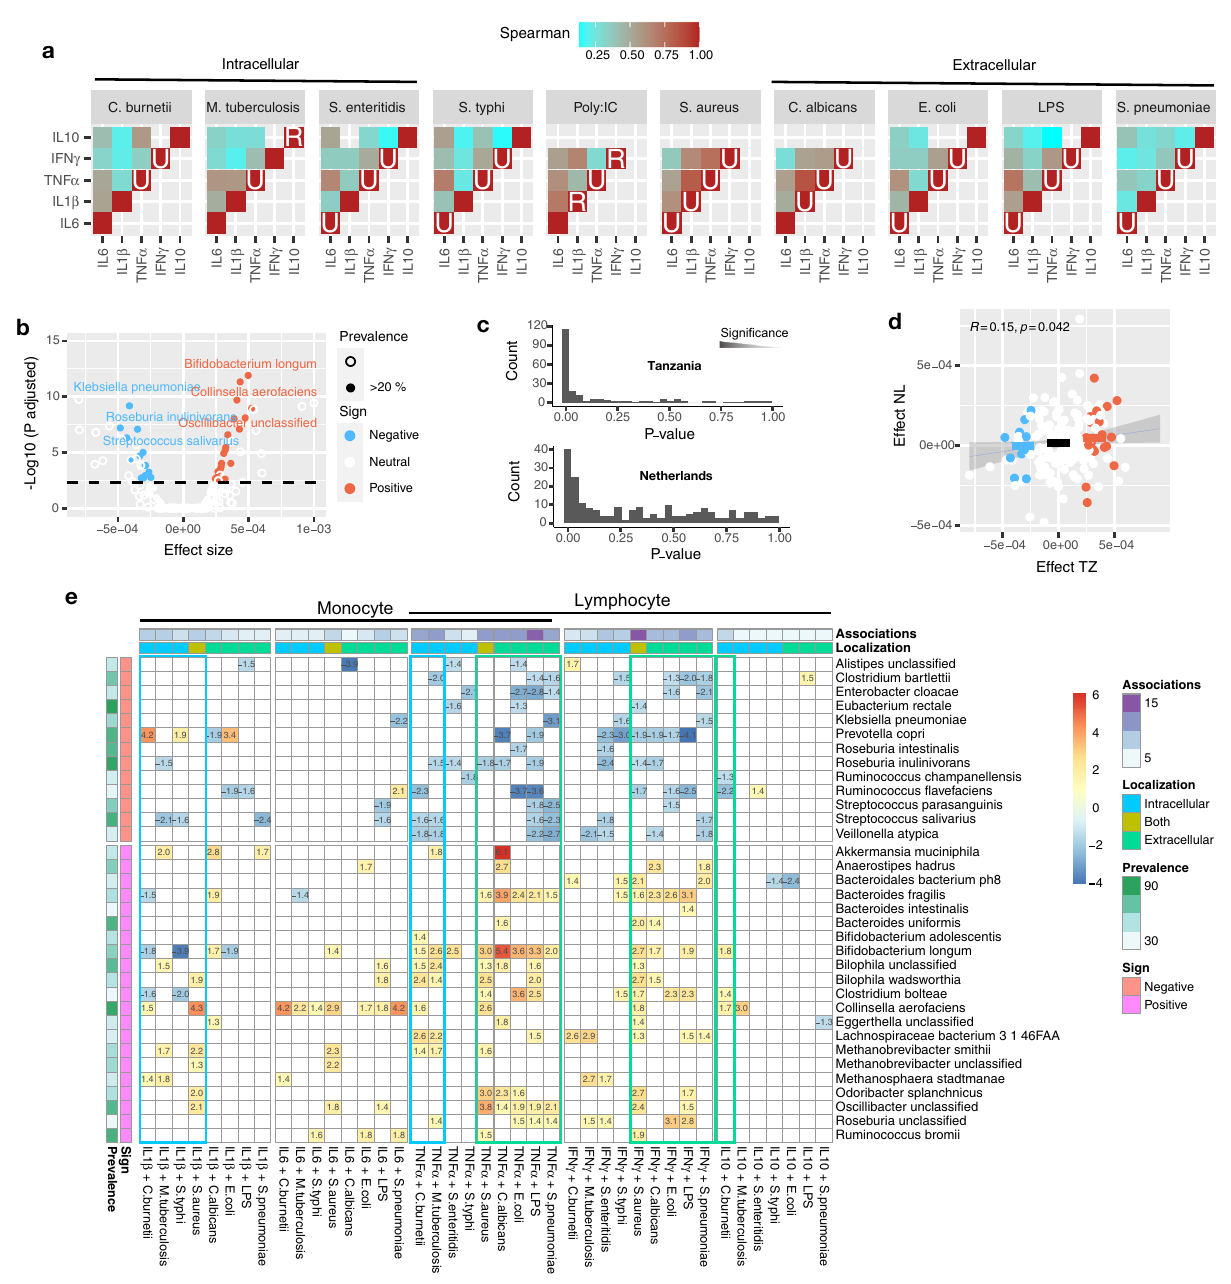
Fig. 3 Identi fi cation of immunomodulatory species. a Whole blood from study participants was stimulated ex vivo with one fungal and seven bacterial stimuli and expression of fi ve cytokines was measured. Heatmaps show signi fi cant Spearman correlations ( P < 0.05) between samples in cytokine responses to all pairs of stimuli. Diagonal cells display signi fi cantly increased levels in urban (U) or rural (R) samples (Wilcoxon rank-sum two-sided test, P < 0.05). b Volcano plot of the species effects in cytokine responses, based on the log-linear model log y p,m,i = β 0 + β d dep i + β m mic m,i + β e eff m + ε p,m,i , where ε c,s,i is the noise, β 0 the intercept, β d the subject sequencing depth, β m microbe abundance, and β e the microbes ’ immunomodulatory ( “ Methods ” ). Immunomodulatory species are further split by negative (13, blue) and positive (21, red) effects subject to P Bonferroni < 0.005 (two-tailed t-test) and prevalence >20%. c Distribution of p -values for each species resulting from the log-linear model used in TZ (top) and NL (bottom) cohorts. d Comparison with the same log-linear model applied to intersecting ex vivo blood cell stimulation from the NL cohort. Macrophages were stimulated with LPS, C. albicans , S. typhi , and M. tuberculosis , and IL-6 and TNF- α were measured. Point colors refer to directionality of immunomodulatory species as in ( b ). e Individual effects of immunomodulatory microbes. Coef fi cients are obtained from a linear model log(Cytokine expression) ~ age + gender + microbe fi t to each individual cytokine and stimulus combination and only signi fi cant values are shown (two-tailed t-test, unadjusted P < 0.05; see Supplementary Data 9 for exact P -values). Source data are provided in the Source data fi